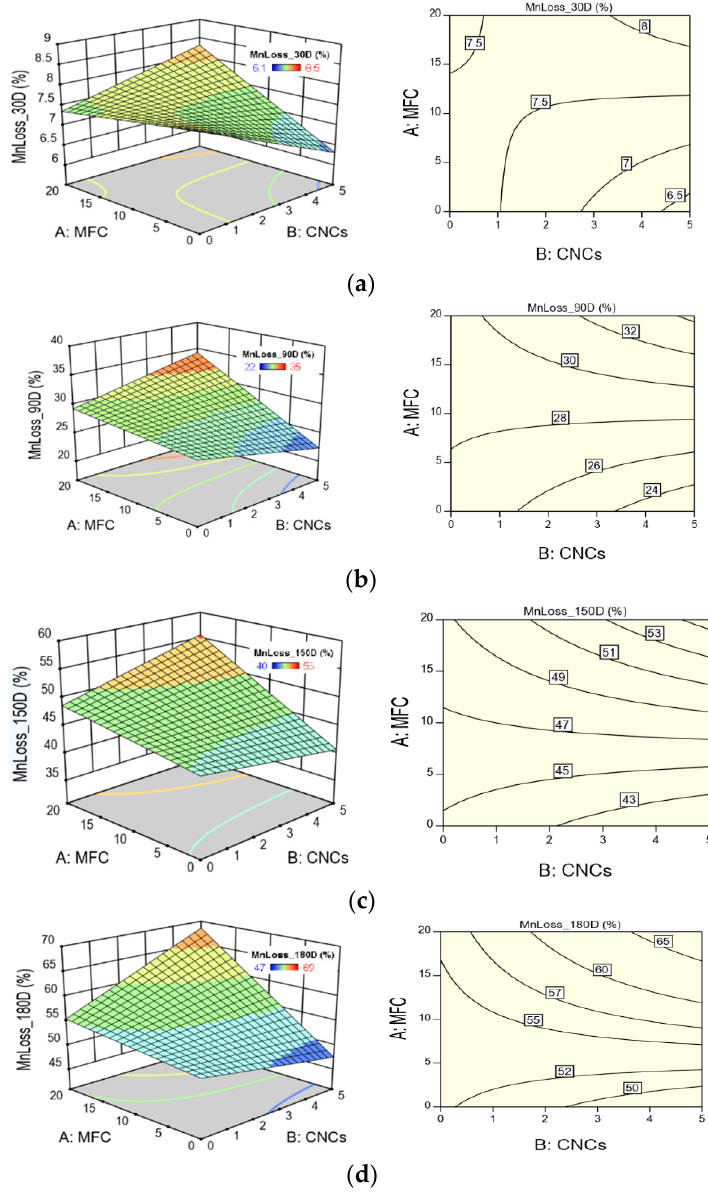
Figure 11. Surface response and contour plots for HBCs Mn loss for ( a ) 30D; ( b ) 90D; ( c ) 150D; ( d ) 180 D incubation